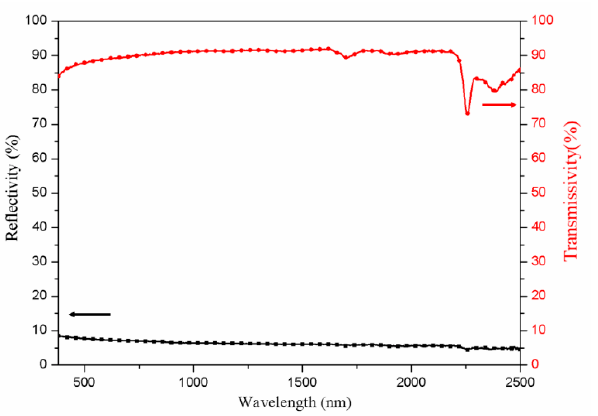
Figure 8. Spectral reflectance and transmittance profiles of polyvinylidene fluoride (PVDF) film.